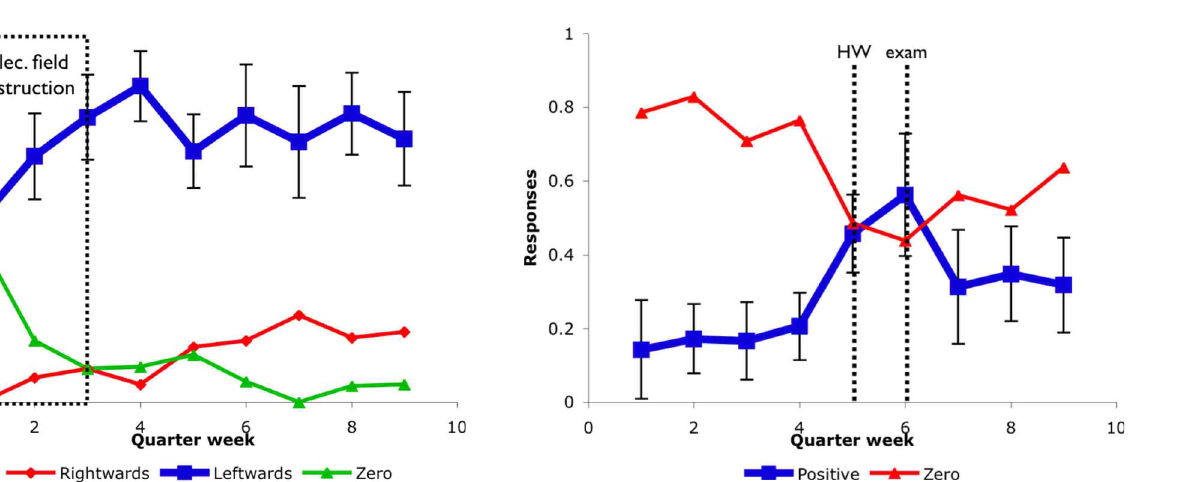
FIG. 2. (cid:1) Color online (cid:2) Responses to a question about the electric field between two charges of opposite signs. The correct answer (cid:1) blue and bold (cid:2) increases when the topic is taught and stays high for the remainder of the quarter. Some minor responses have been omitted.